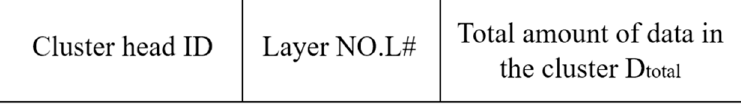
Figure 4. RTS packet format of cluster head node (CH).